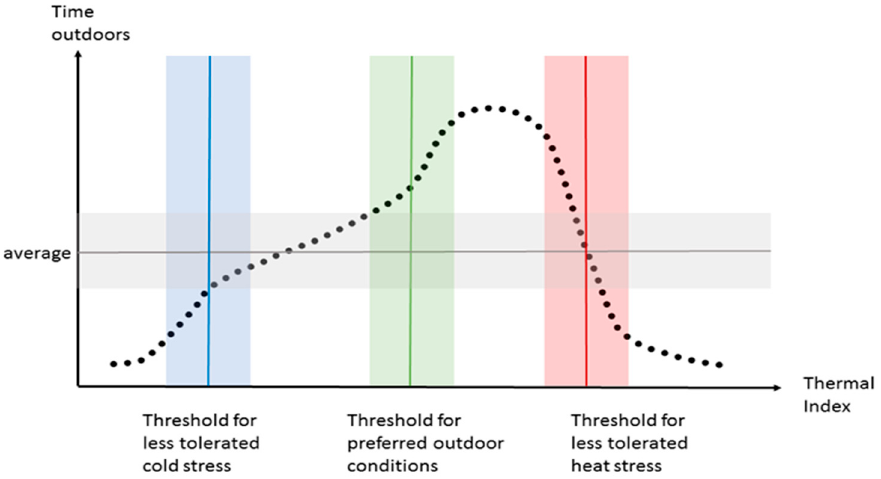
Figure 3. Conceptual model for the relationship between outdoor time and thermal